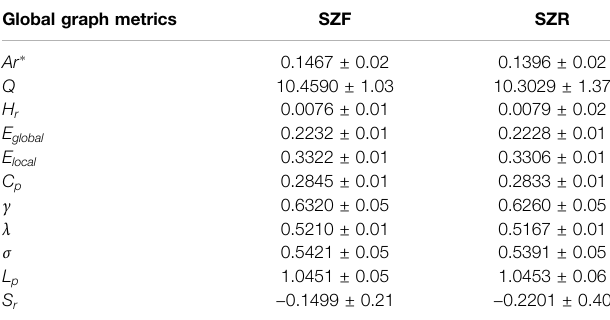
TABLE 2 | Global and local graph metrics of the metabolic brain